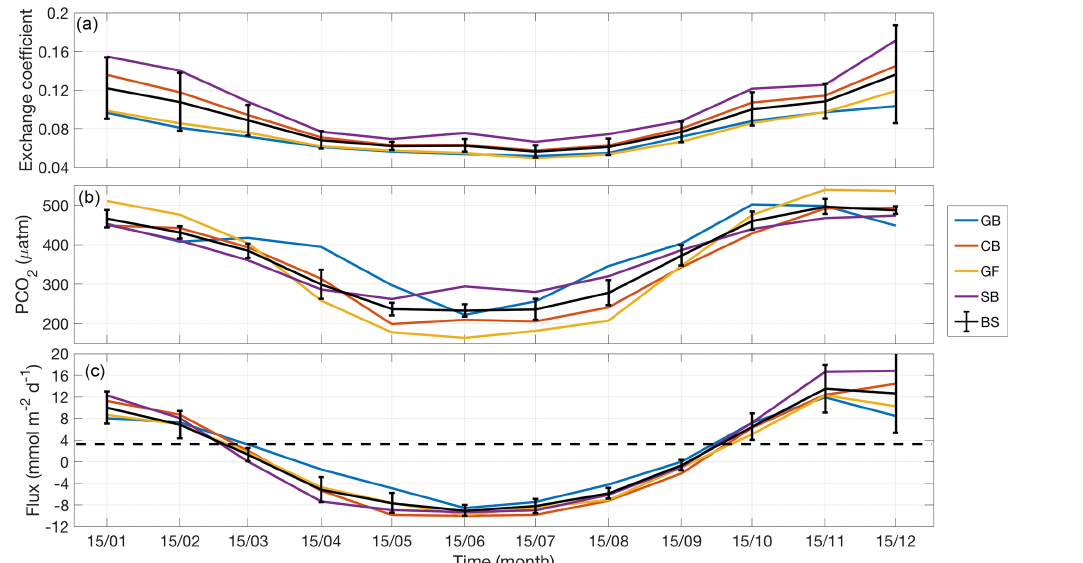
Figure 3. Annual evolution of the (a) transfer velocity based on Wanninkhof et al. (2009). (b) P CO 2 and (c) air–sea CO 2 flux based on the SMHIp wind product for each basin.